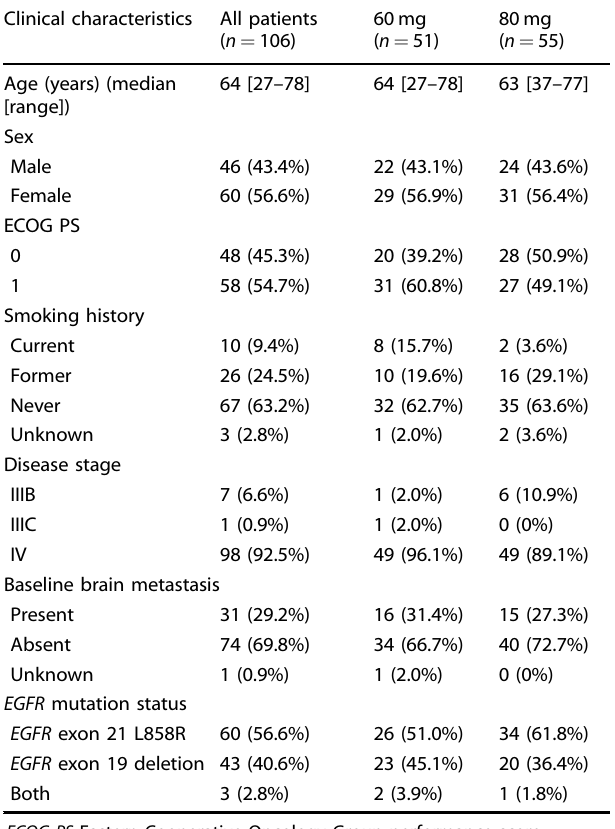
Table 1. Baseline clinical characteristics of the enrolled patients Clinical